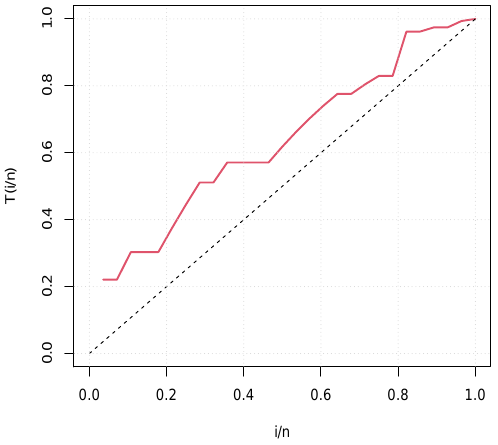
Figure 5. Total time on test (TTT) plot of the times of infection data set.